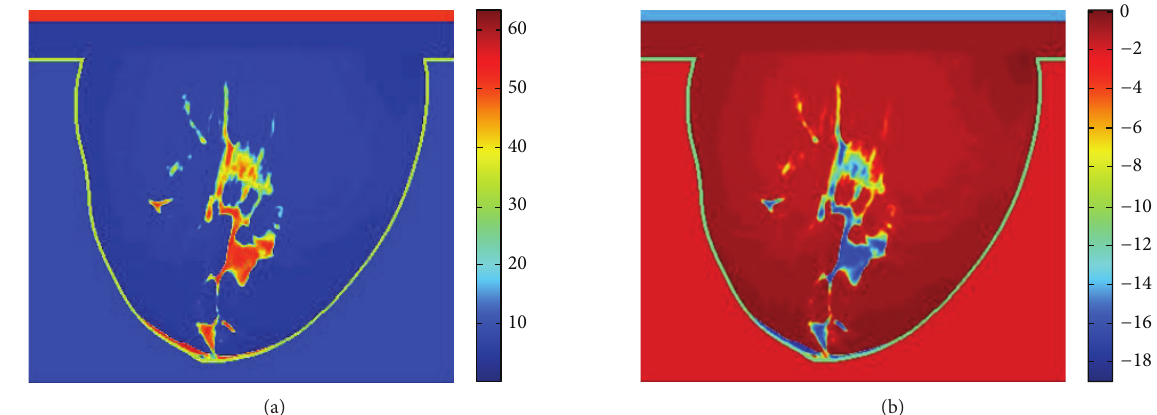
Figure 13: The permittivity in a sagittal slice through full-resolution MRI-derived numerical breast phantom 1 from ACR class 1 at 2 GHz. The cell size is 0.5 mm. Real part (a) and imaginary part